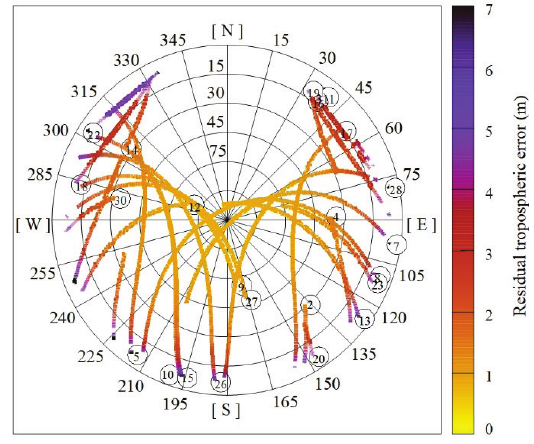
Figure 10. Simulation of the residual tropospheric error in meters (GBAS mode). Altitude difference 3000